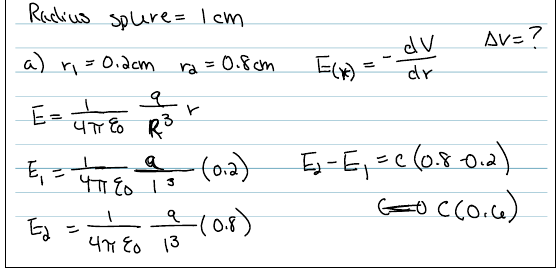
FIG. 8. Kara ’ s initial, recursive plug-and-chug solution to the electrostatics problem.